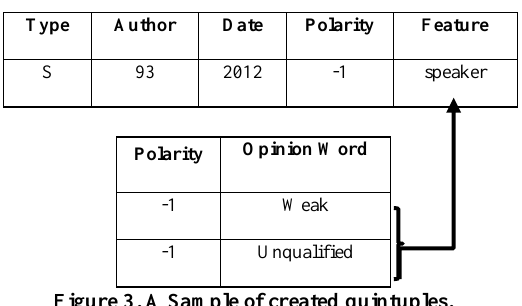
Figure 3. A Sample of created